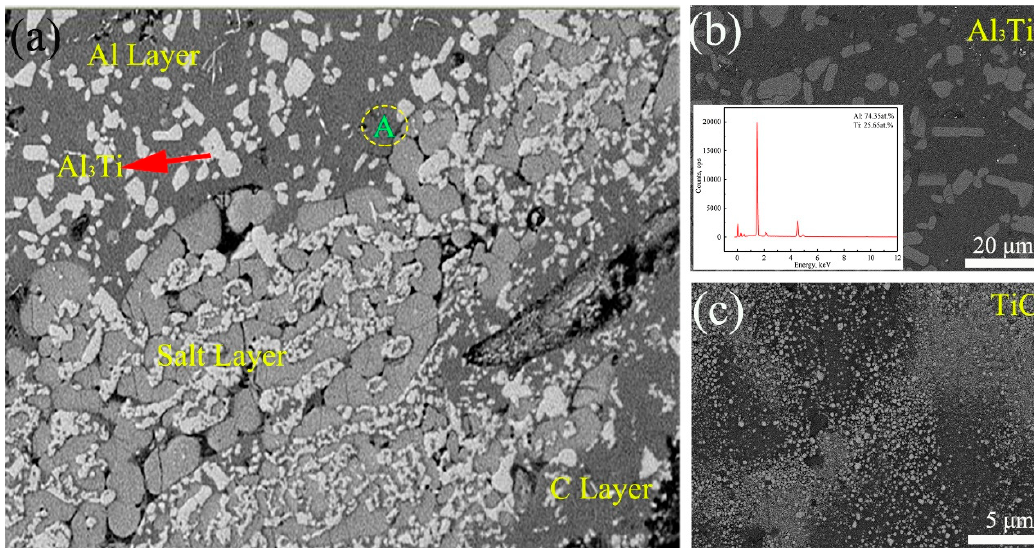
Figure 10. The Al-C interface morphology of the sample, ( a ) the SEM of sample, ( b ) the SEM of Al 3 Ti, ( c ) the enlarged SEM of the area A.